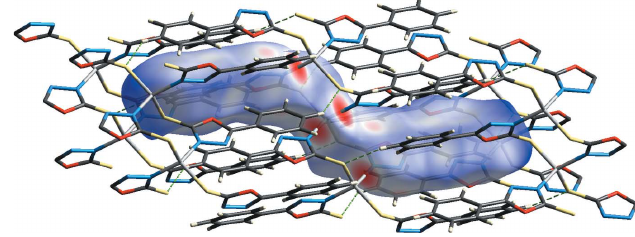
Figure 5 Contributions of the various contacts to the fingerprint plot built using the Hirshfeld surface of the title compound.